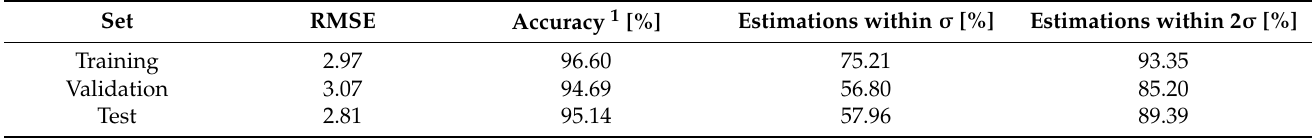
Table 4. Performance indicators for the combined OD soft sensor for all four